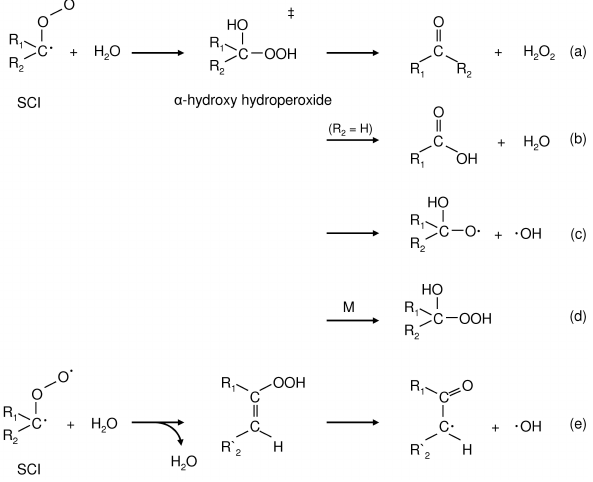
Fig. 8. Mutual constraints of the formation of OH and pinonalde- hyde where CI denotes for Criegee Intermediate; SCI for Stabilized Criegee Intermediate; PAc for Pinonic Acid and PA for Pinonalde- hyde. Details of the reaction sequences following S2 can be seen in Scheme 1 and Scheme 2. Determined branching ratios valid for 303K at humid conditions are given in brackets.